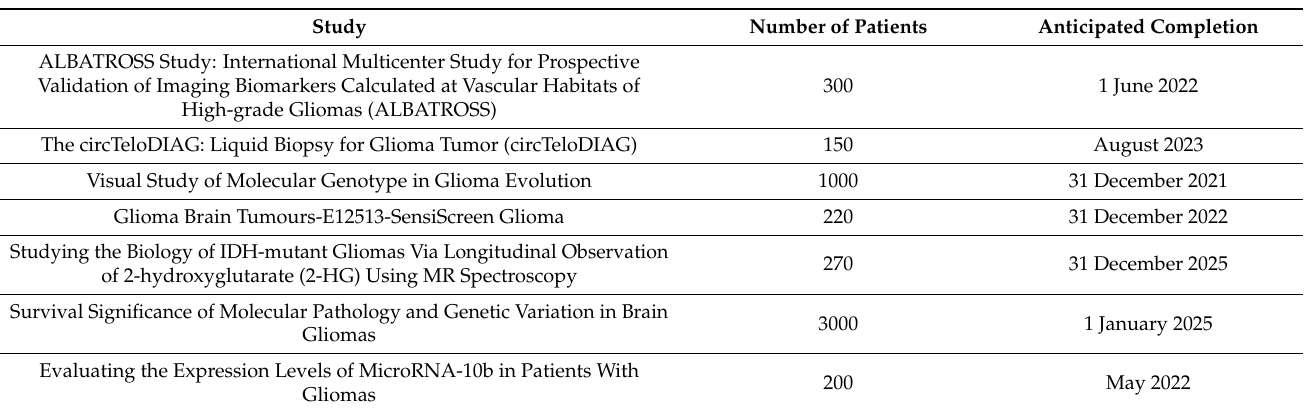
Table 5. Glioma trials aimed at biomarker identification with estimated enrollment exceeding 100 participants